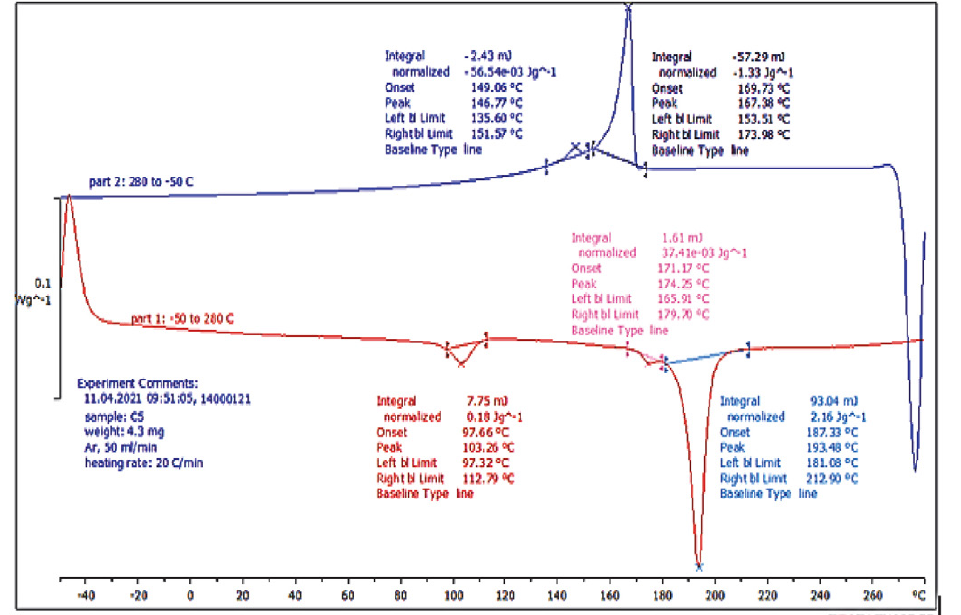
Figure 6: DSC of compound B5 during heating/cooling